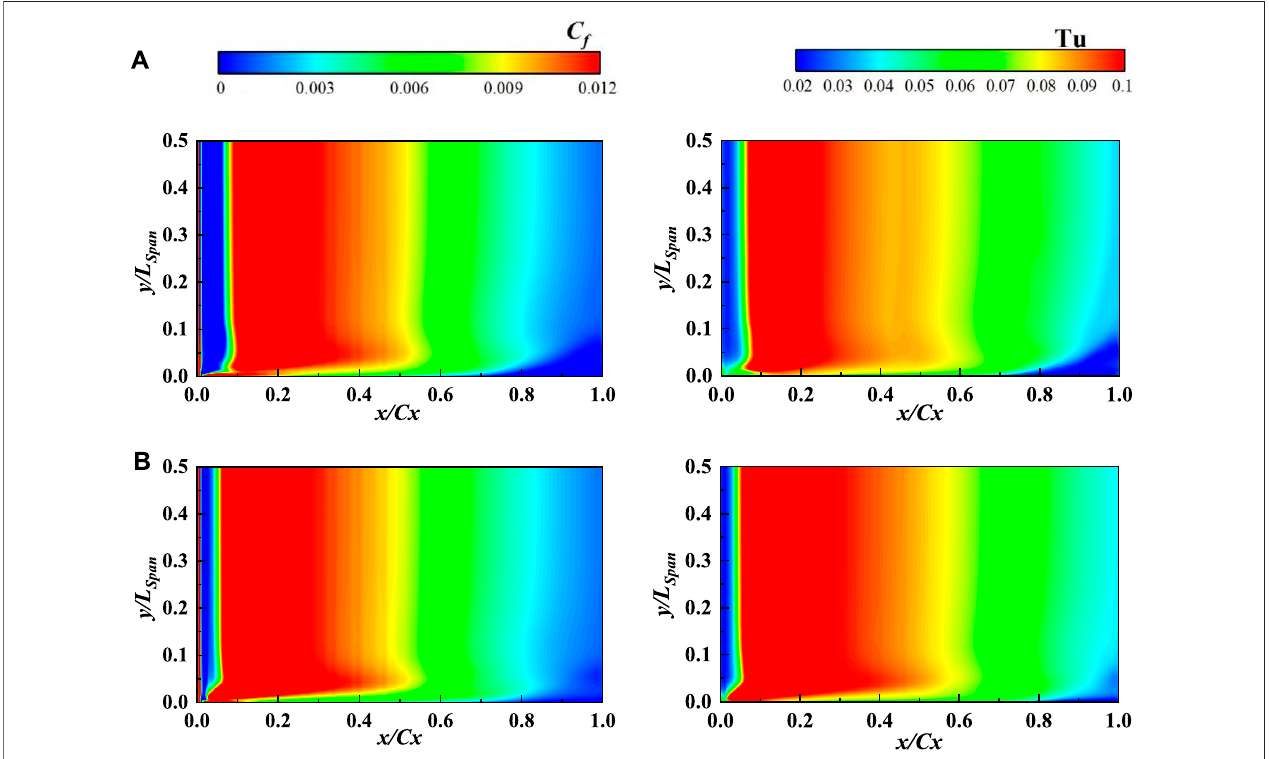
FIGURE 10 | Effect of roughness on cascade total pressure loss at different Reynolds numbers.